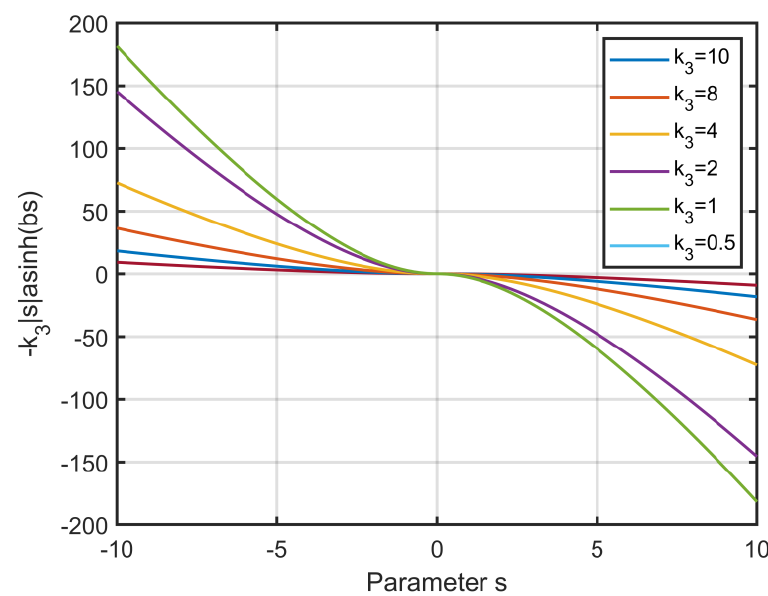
Figure 1. Plot of −𝑘 3 |𝑠|asinh (𝑏𝑠) with 𝑏 = 0.3 .